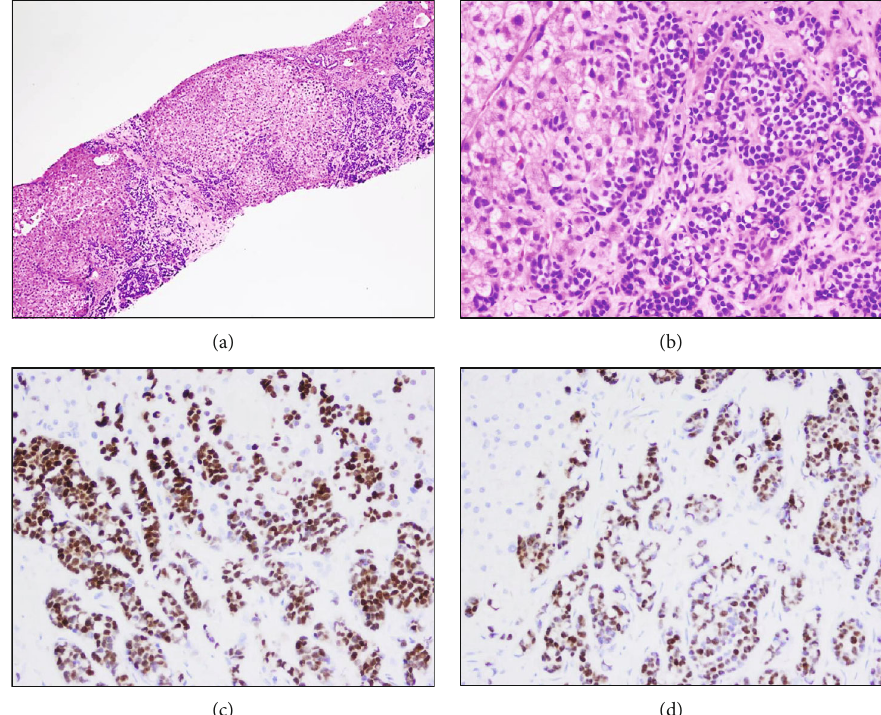
Figure 3: Di ff usely in fi ltrating nests of intermediate-grade ductal adenocarcinoma with disrupted hepatic parenchyma (H&E) ((a) 100x and (b) 400x). Tumor cell nests staining for estrogen (c) and progesterone (d)